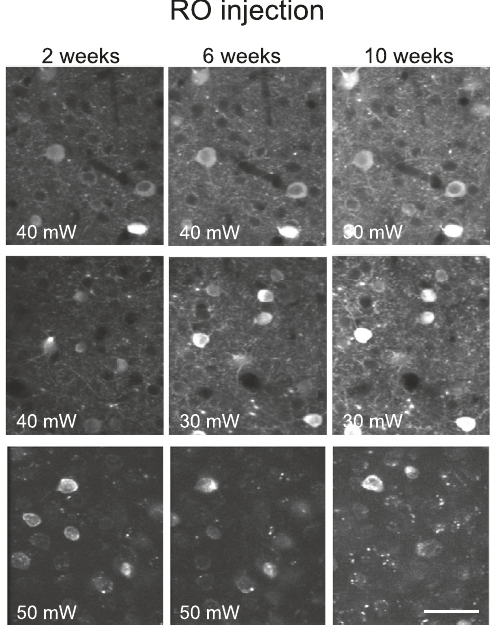
Fig. 4 | Expression over time of jGCaMP8 and soma-targeted jGCaMP8 using RO and IC virus injections. Note the dramatic reduction in illumination power (noted in the bottom left corner) used for jGCaMP8s and the EE-RR versions when expressed byanIC injection.RO injectedjGCaMP8sandEE-RR-jGCaMP8sgaverise to very stable expression levels. For RiboL1-jGCaMP8s RO injections the signal was